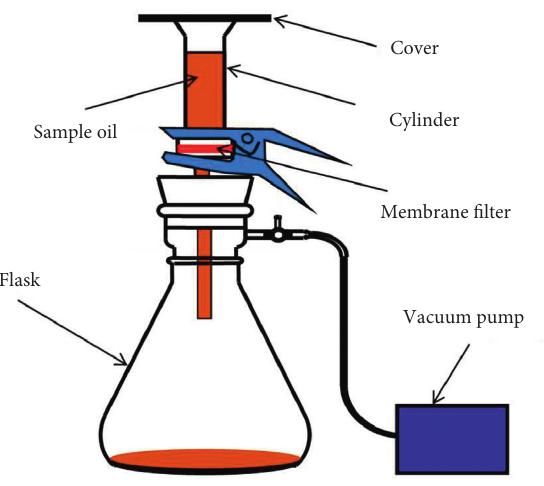
Figure 1: Filtering